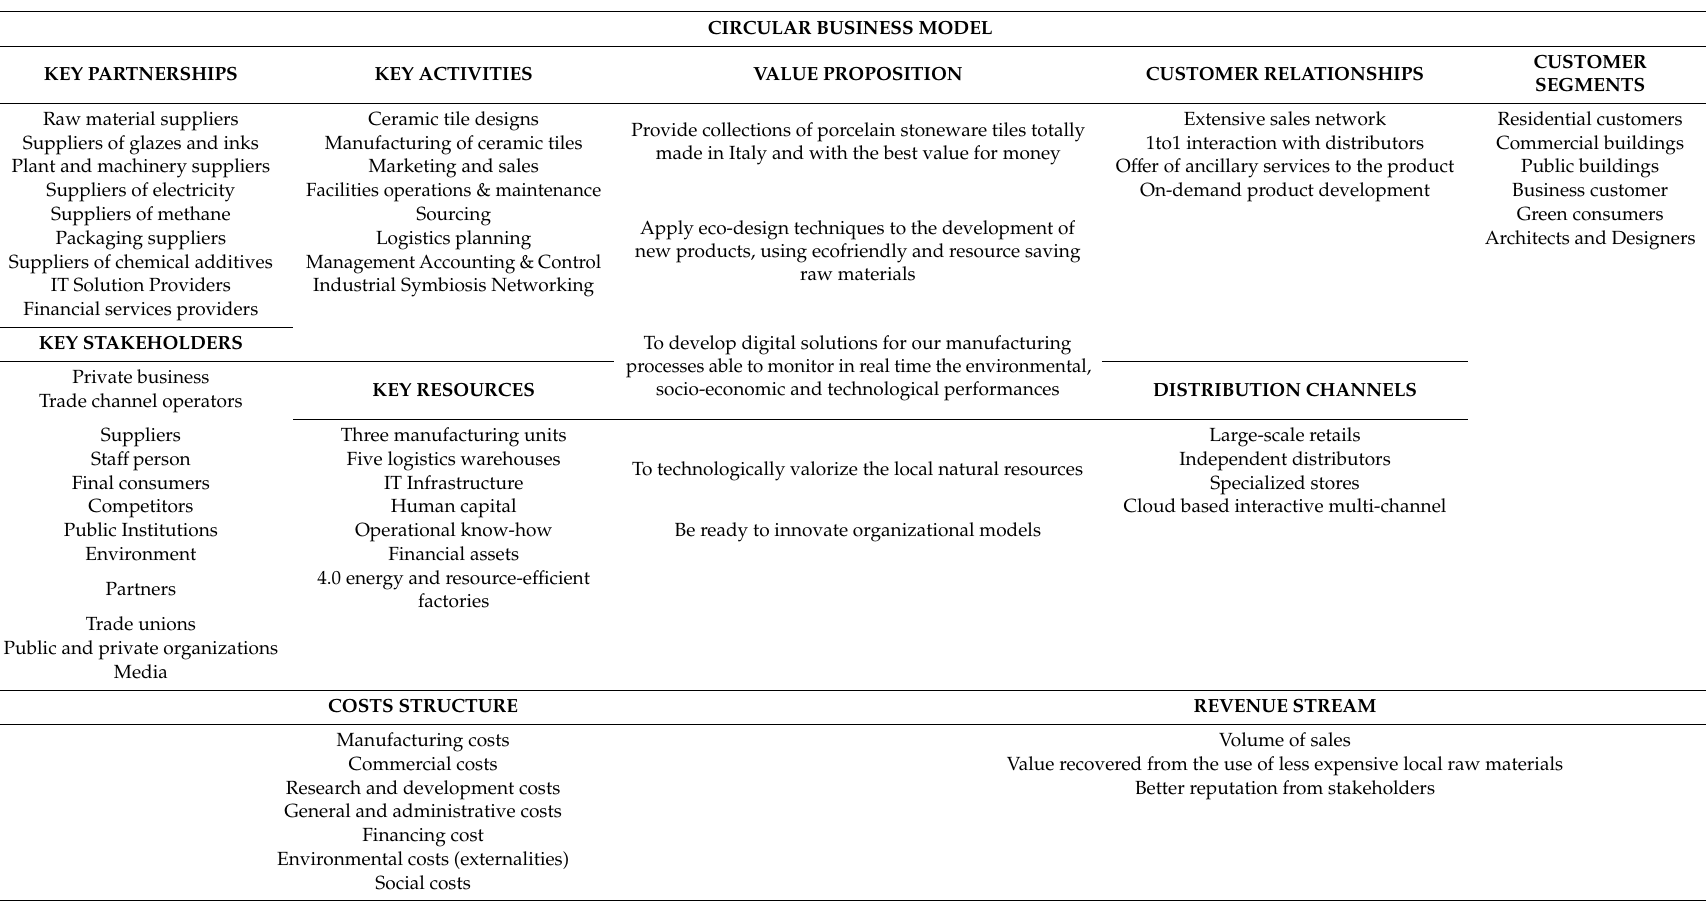
Table 6. Representation of the updated circular business model inspired by the business model canvas. CIRCULAR BUSINESS